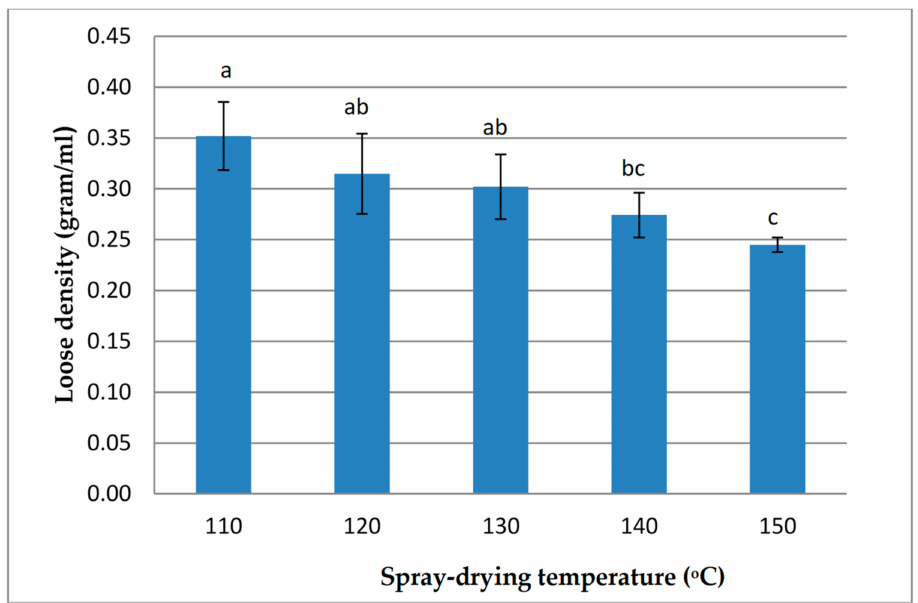
Figure 1. Loose density (g/mL) of lemongrass leaf extract powders at different spray-drying temperatures. All data are the mean ± SD. Values with different letters are significantly different ( p < 0.05).